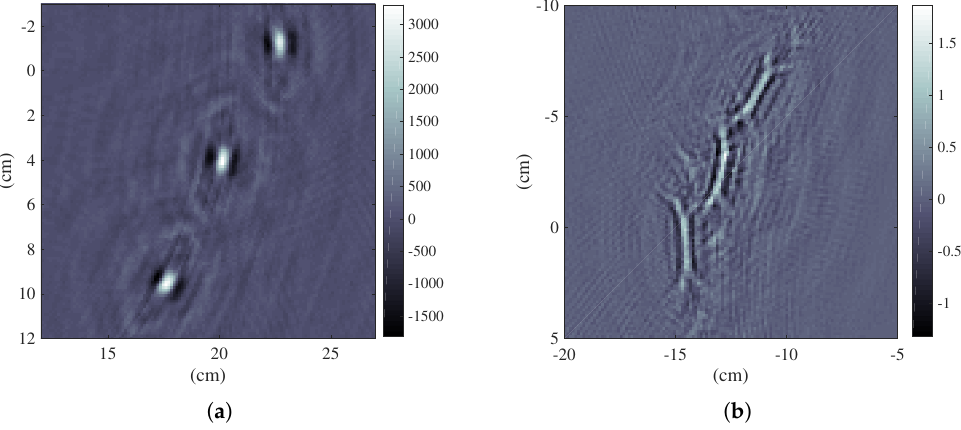
Figure 7. Reconstructed radar images and pictures of the targets. ( a ) The near-field radar image of the pins; ( b ) The radar image of the pins regarded as the far range.;